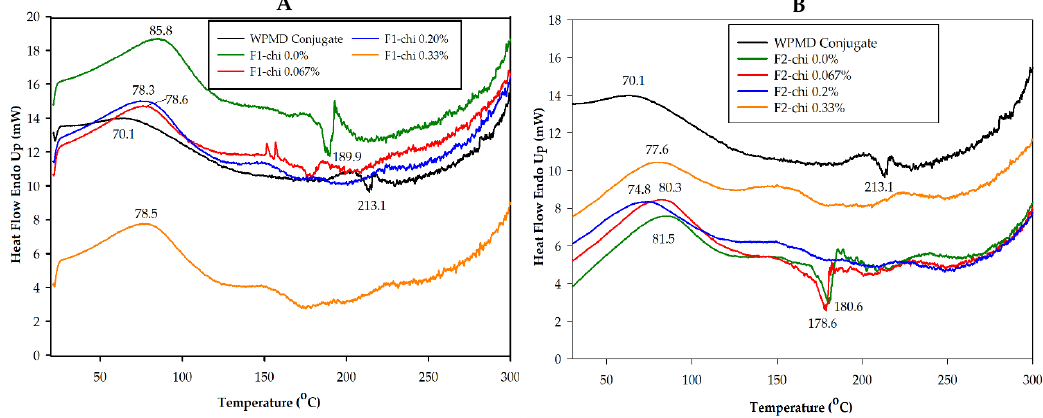
Figure 1. Di ff erential scanning calorimetry (DSC) thermogram of F1 ( A ) and F2 ( B ) spray-dried powders